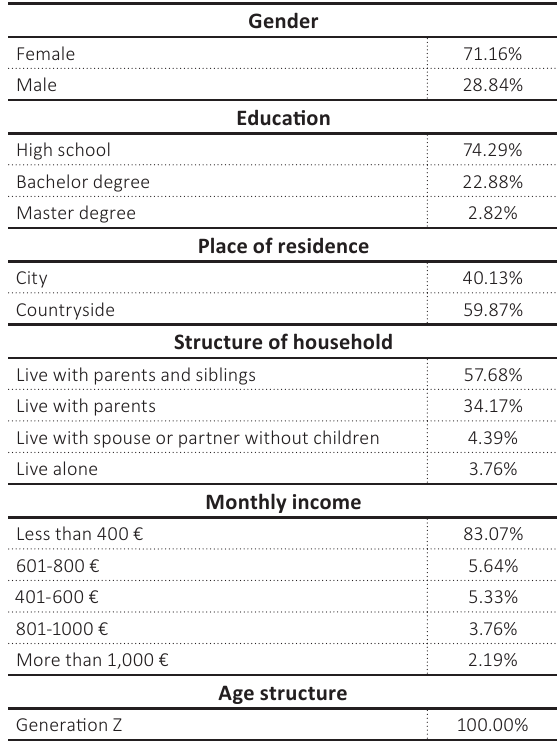
Table 1. Structure of the sample survey and blind test